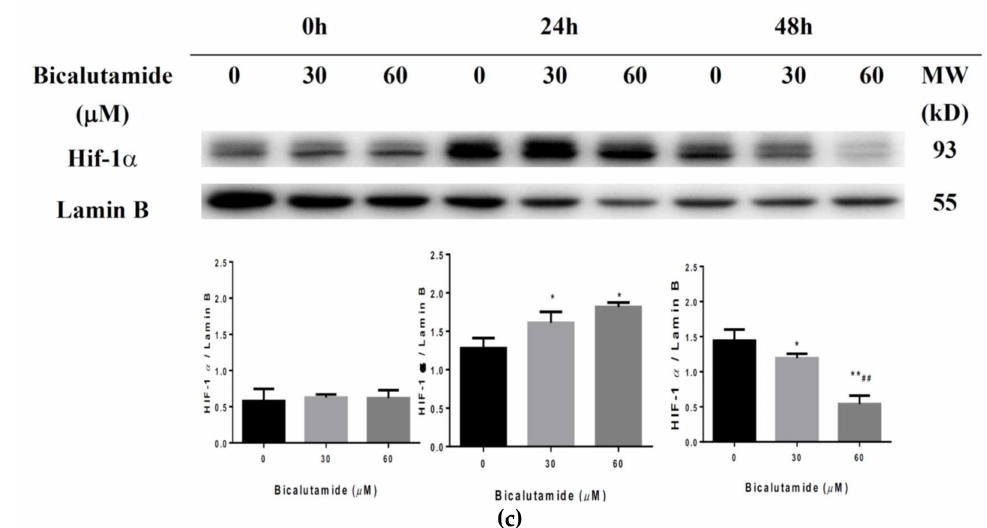
Figure 5. ( a ) Hypoxia-inducible factor (HIF)-1 α transcriptional activity assay. Cells were untreated or treated with bicalutamide (Bic) at doses of 30 and 60 µ M for 3–24 h and hif-1 α transcriptional activity was analyzed with a commercial kit (Cayman). Hif-1 α transcriptional activity had only increased at 24 h after treatment with Bic. ( b ) Quantitative polymerase chain reaction (qPCR) for hif-1 α mRNA. Rat mesangial cells (RMCs) were treated with Bic at doses of 30 or 60 µ M for 24 h. Total RNA was extracted and reverse-transcribed to cDNA. hif-1 α mRNA was detected according the protocol of a commercial SYBR green QPCR kit (Taigen Bioscience). Hif-1 α mRNA dose-dependently increased. ( c ) Western blot analysis of the HIF-1 α protein in RMC cells. Cells were treated with the indicated doses of Bic for 0–48h. Nuclear proteins were subfractionated from total cell lysates and loaded onto SDS-PAGE gels. Blots were detected using antibodies of HIF-1 α and lamin B. Lamin B was used as an internal control. Levels of HIF-1 α protein expression were quantified by Image J software and normalized to that of lamin B. Representative images are shown and quantitative data are from three replicates. Data are expressed as the mean ± standard deviation. * p < 0.05, ** p < 0.01 compared to untreated cells; # p < 0.05, ## p < 0.01 compared to 30 µ M Bic-treated cells. 2.6. Bic Induced Cell Apoptosis via BNIP3-Caspase 3 Signaling and Modulation of HIF-1 α Partially Inhibited Cell Death in